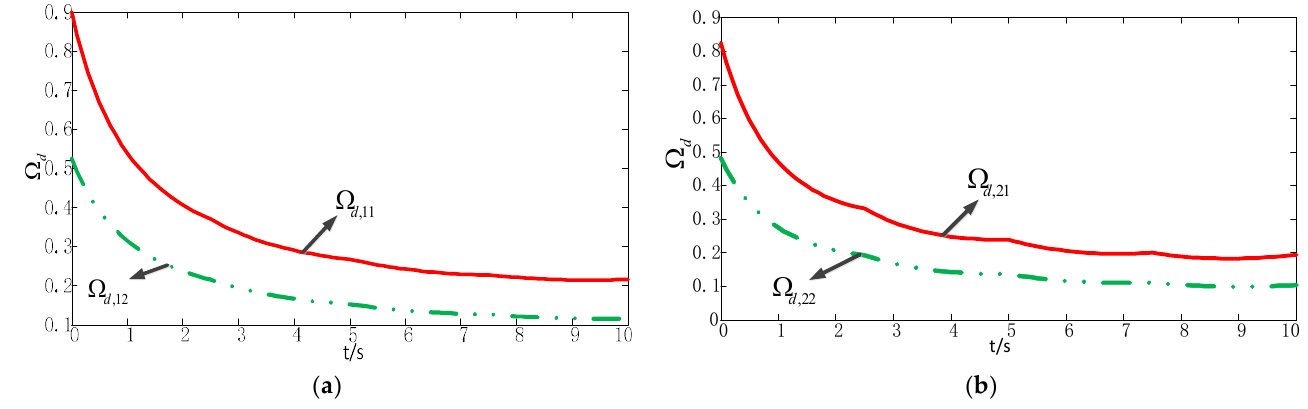
Figure 4. Stability comparison along the given spatial spiral trajectory when s = 1, t = 1, 2 and s = 2, t = 1, 2: ( a ) comparison of the stability with s = 1, t = 1 and s = 1, t = 2; ( b ) comparison of the stability with s = 2, t = 1 and s = 2, t = 2.